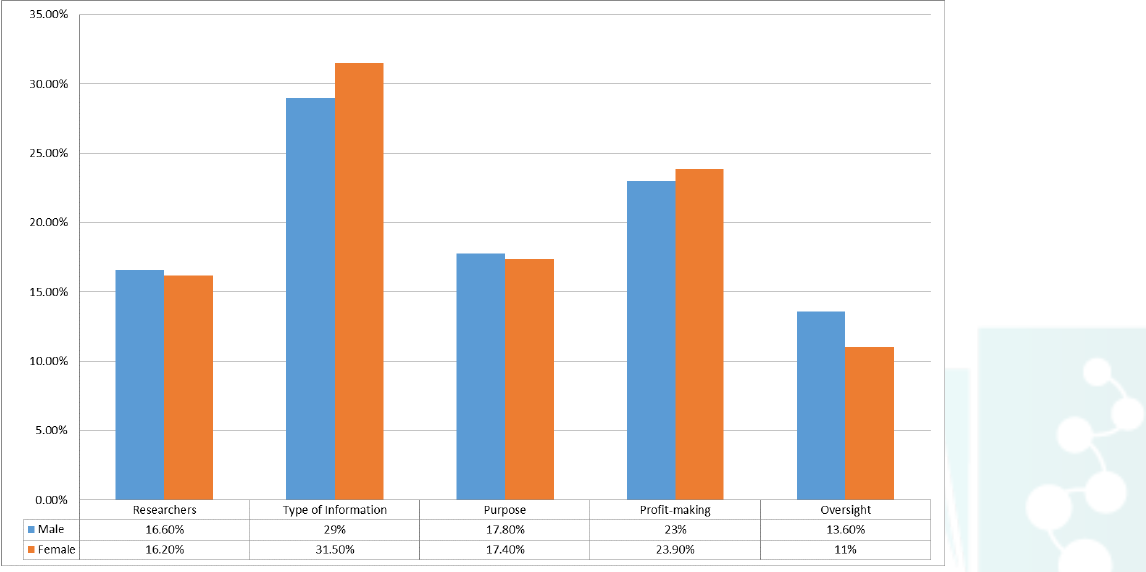
Figure 3: Relative Importance of Attributes for Male and Female